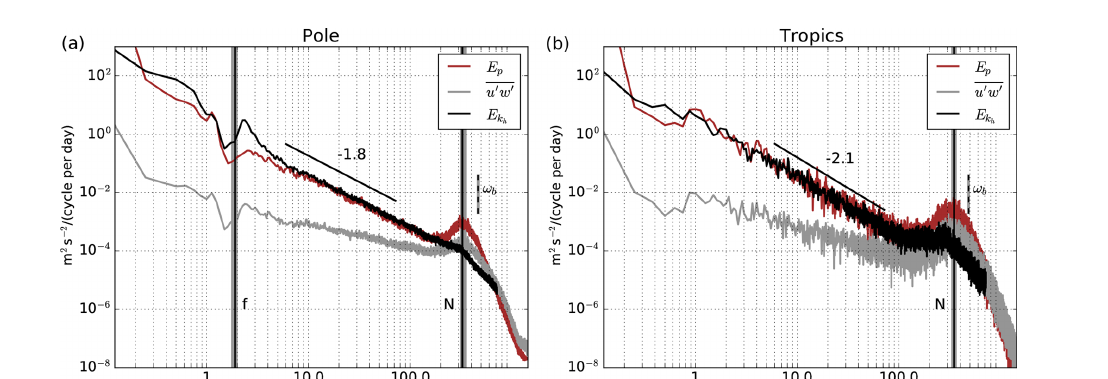
, potential energy E p and | u (cid:48) w (cid:48) | inferred from SPB observations during the h